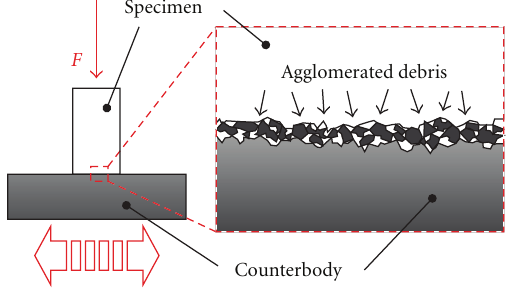
Figure 3: Fretting concept—third body e ff ect.